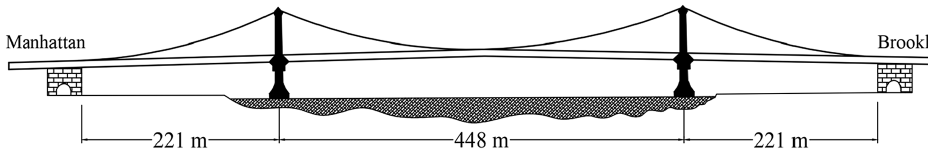
Figure 6. Picture and description of the section of the bridge.